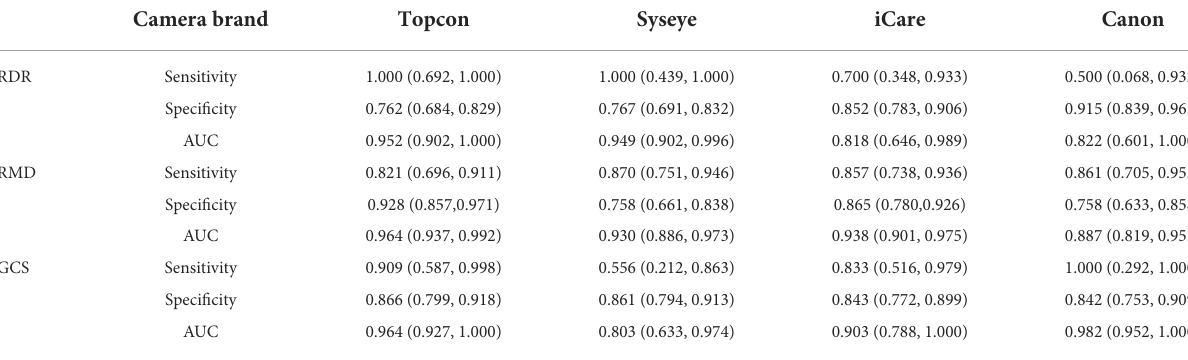
TABLE 4 Prediction performance of the baseline model on RDR, RMD, and GCS across